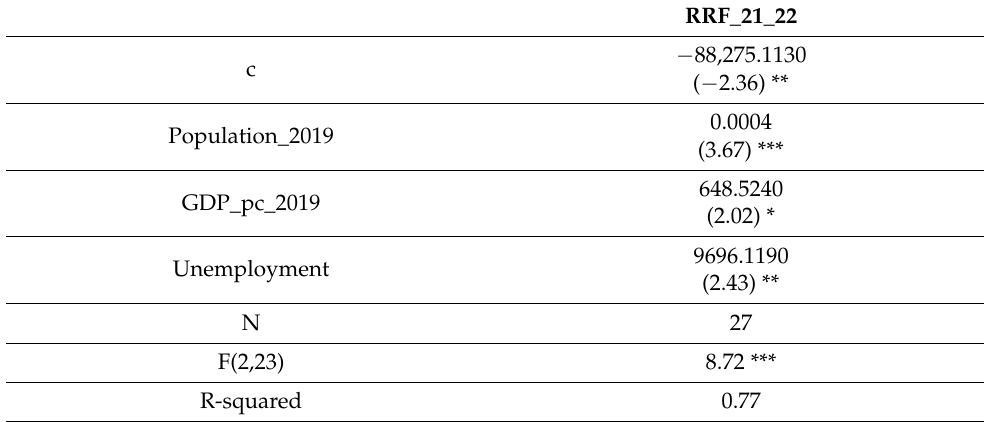
Table 5. Relationship between the different socioeconomic criteria for the distribution of grants established by the European Commission (2021–2022) and the amount of grants that Member States will actually